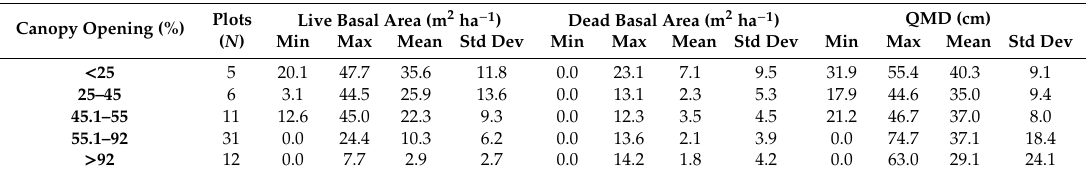
Table 2. Remaining live and dead overstory tree density (basal area) and diameter (quadratic mean diameter (QMD) by canopy opening class.